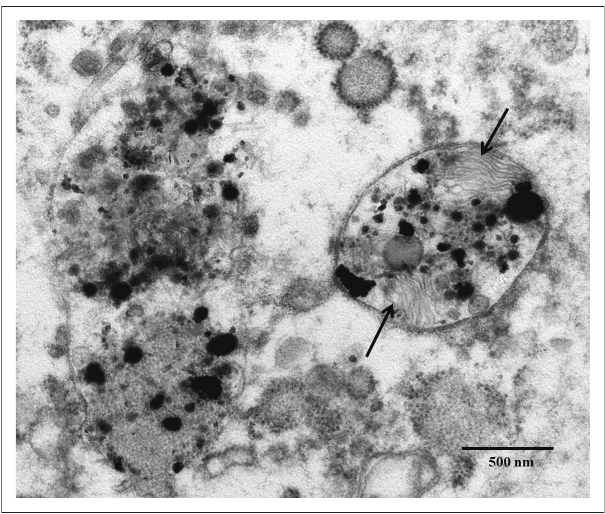
Source : Image taken by Erna van Wilpe FIGURE 4: Interruption of the typical lamellar pattern (arrows) of the secretory vesicles of type II pneumocytes by the deposition of electron-dense material (electron microscopy/ EM).